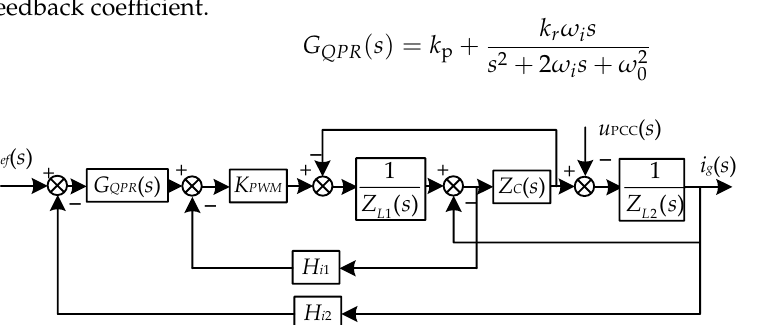
Figure 1. A structure diagram of an LCL inverter.